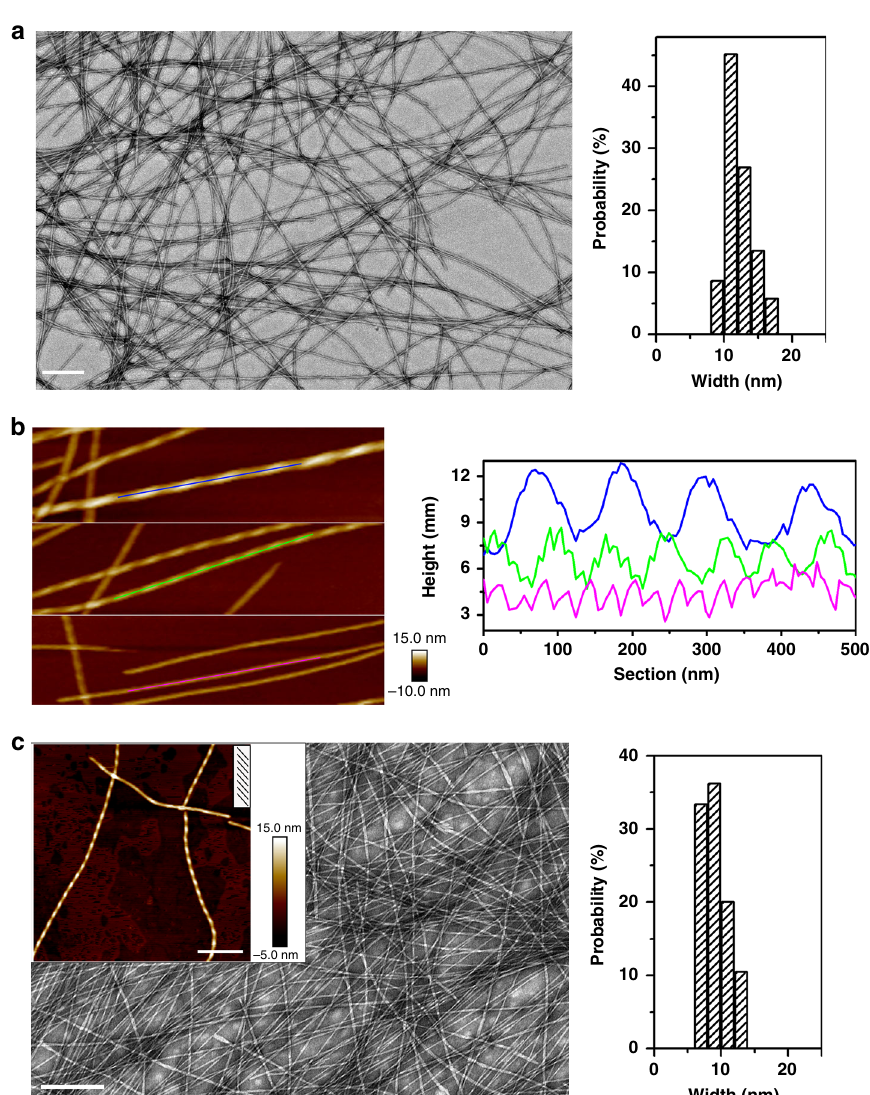
Fig. 5 Nano fi bers formed by Ac-I 3 GGK-NH 2 and Ac-I 3 nor VGK-NH 2 at pH 7.0 after incubation for 1 week. a TEM micrograph (left panel) and width distribution histogram of 16 mM Ac-I 3 GGK-NH 2 nano fi bers (right panel, based on measurements of ~100 individual fi bers). Scale bar, 200 nm. b Magni fi ed height AFM image of Ac-I 3 GGK-NH 2 nano fi bers (left panel) and corresponding sectional height pro fi les along the fi ber axis showing fi ber polymorphism (right panel). c TEM micrograph (left panel) and width distribution histogram of 8 mM Ac-I 3 nor VGK-NH 2 nano fi bers (right panel, based on measurements of ~100 nanoobjects), with an inset AFM imaging in the left panel indicating their left-handed twisting. Scale bar represents 200 and 300 nm the TEM and AFM images,